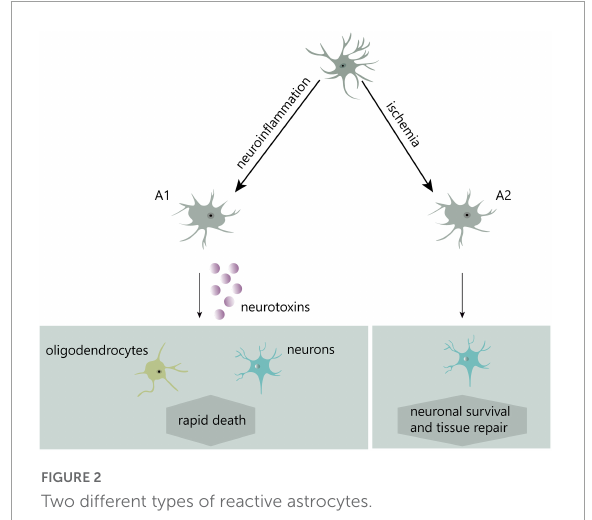
FIGURE2 Two different types of reactive